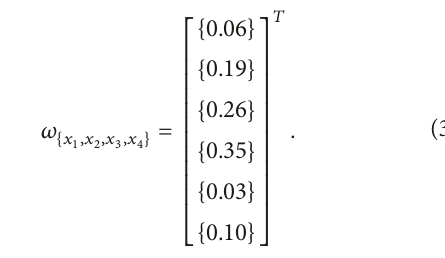
Table 11 describes the results. Step 2. State the preferences of the criteria. Table 12 illustrate the